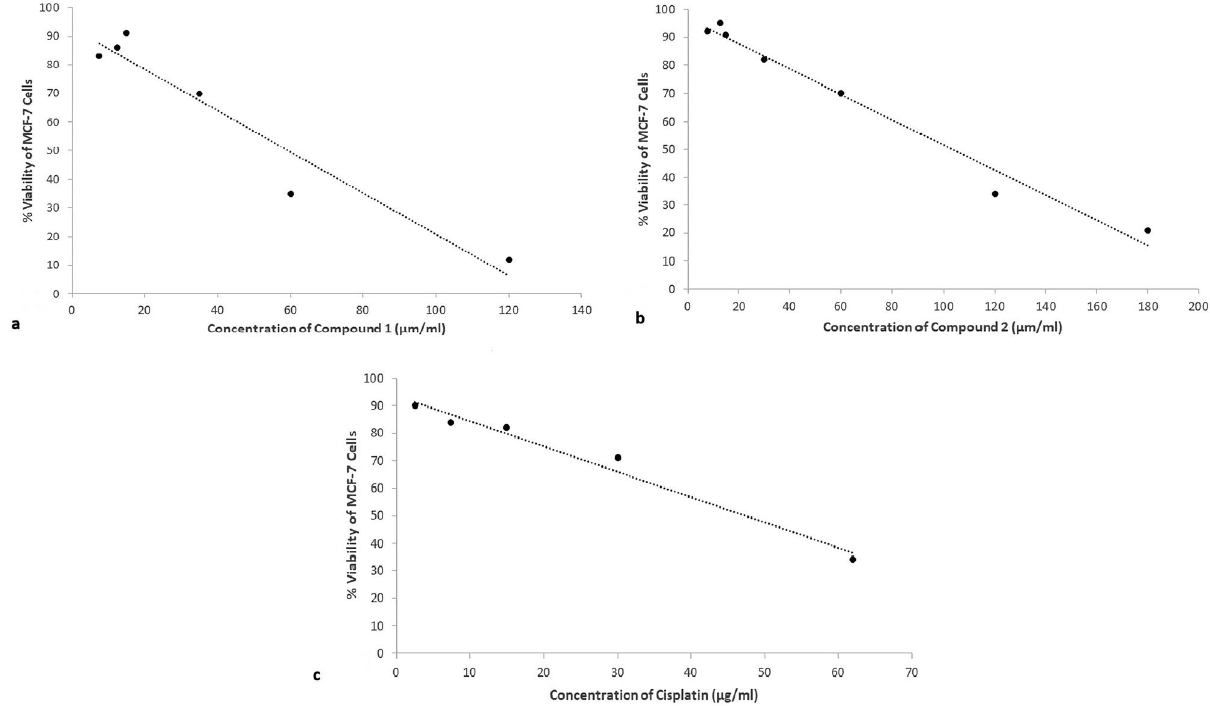
Figure 5. Cytotoxicity of O. dentata against MCF-7 cells: the graphs shows the cytotoxicity of ( a ) compound 1 and ( b ) compound 2 purified from O. dentata compared to ( c )